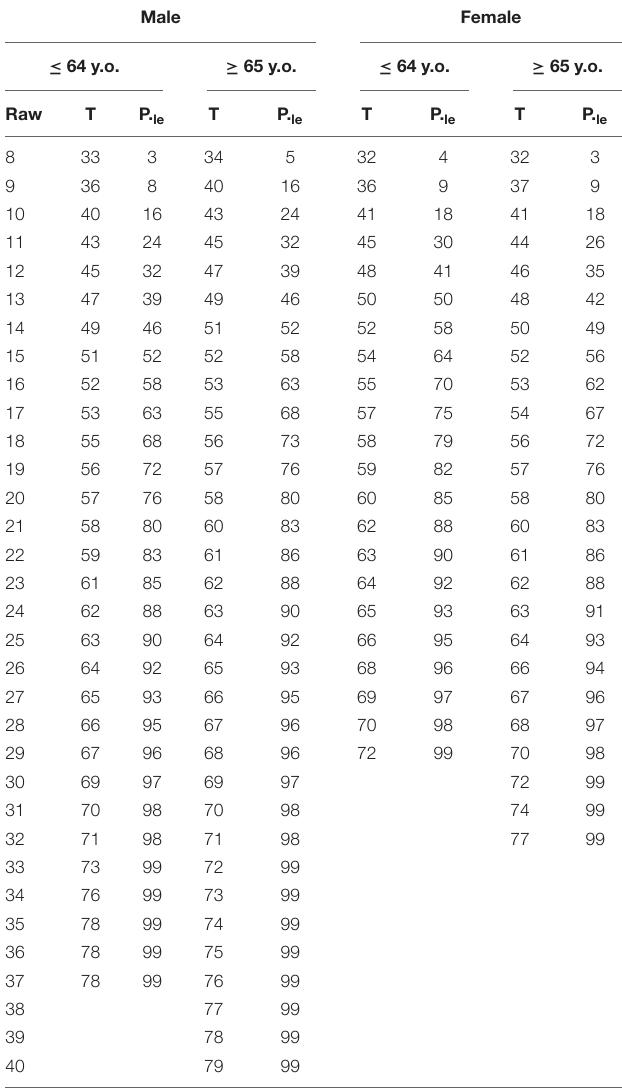
TABLE 6 | Study 1 plus Study 2. Normative scores (T-scores) and percentile distribution for gender and age. Male Female ≤ 64